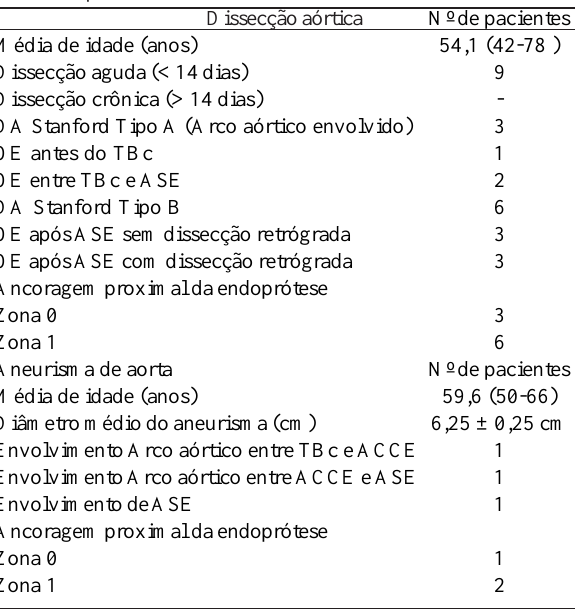
Tabela 2. Dados clínicos e características anatômicas dos